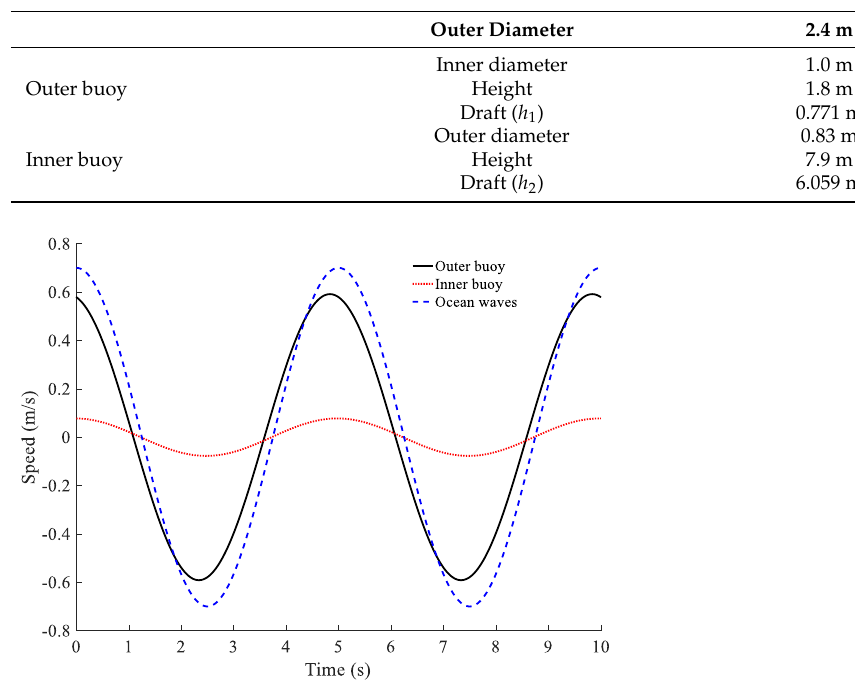
Table 1. The basic parameters of double buoys.